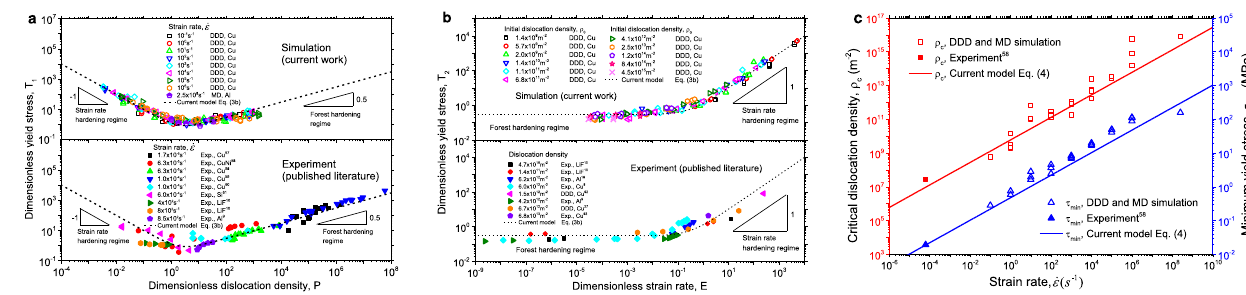
Fig. 3 Comparison of our models, simulation data with published experiments 8 – 10,16,27,57 – 63 . a Dimensionless yield stress versus dimensionless dislocation density; b dimensionless yield stress versus dimensionless strain rate; c minimum yield stress and critical dislocation density at the transition point between forest hardening and strain rate hardening regimes, as a function of strain rate. All DDD/MD and experimental data presented in this fi gure are shown in Supplementary Data 2. DDD is abbreviation of discrete dislocation dynamics and MD is